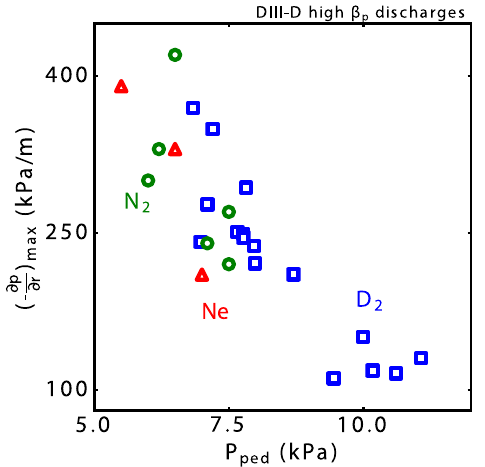
Fig. 7 Plasma parameters for a high- β p discharge with detachment via neon seeding. a β N (red), β p (black), and H 98 (blue). b Neon gas puf fi ng rate (blue) and divertor T e near the outer strike point. c The peak electron pressure (red) and pedestal top electron pressure measured by the Thomson Scattering diagnostic system. d ITB pressure gradient and peak heat fl ux measured by an IR